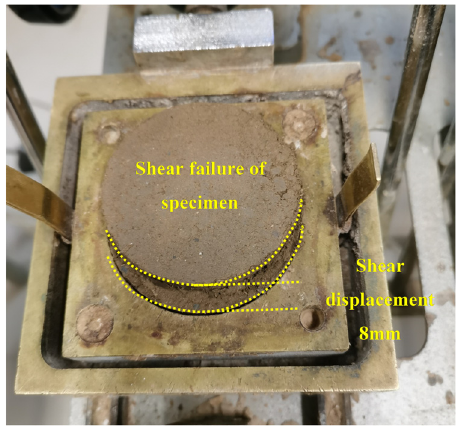
Figure 11: Electron